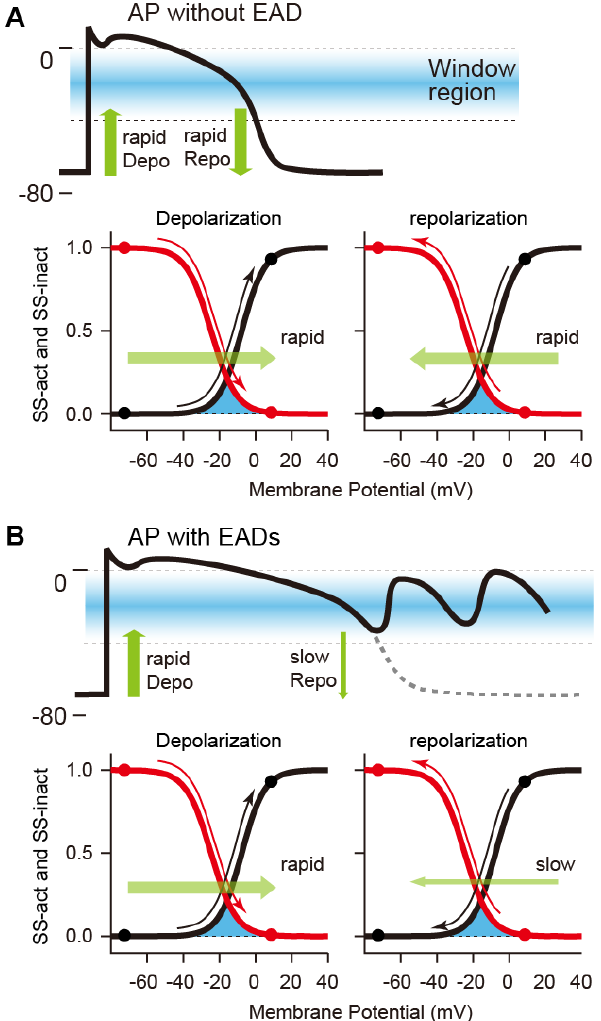
Figure 2. Relationships between membrane potential changes in response to depolarization and repolarization in a normal AP without EAD ( A ) and an abnormal AP with EADs ( B ) and voltage- dependent activation/inactivation of the L-type Ca 2+ channel. Excessive APD prolongation due to slow repolarization leads to a long-lasting stay of the membrane potential in the L-type Ca 2+ channel current ( I CaL ) window current region (blue areas), resulting in large reactivation of I CaL . SS-act: steady-state activation curve (black lines); SS-inact: steady-state inactivation curve (red lines); Depo: depolarization; Repo: